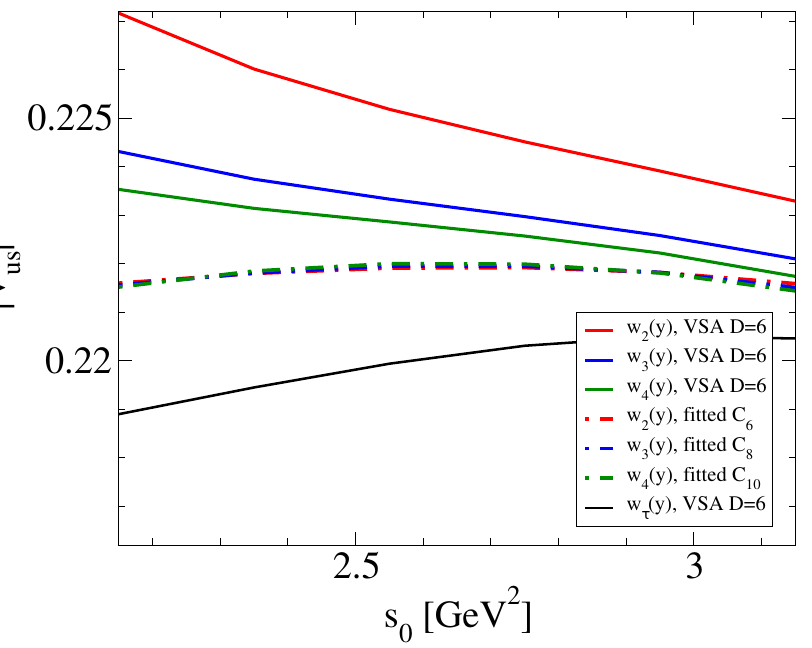
- and weight-stability test results. Solid lines show the s Figure 2: s 0 | V | obtained from the w , w , w and w τ FESRs with the conventional implementation us 2 3 4 (cid:39) C VSA = 0 . The dashed lines show the corresponding w assumptions C and C 6 8 6 and w results obtained using instead the central values for C 4 from the alternate FB FESR